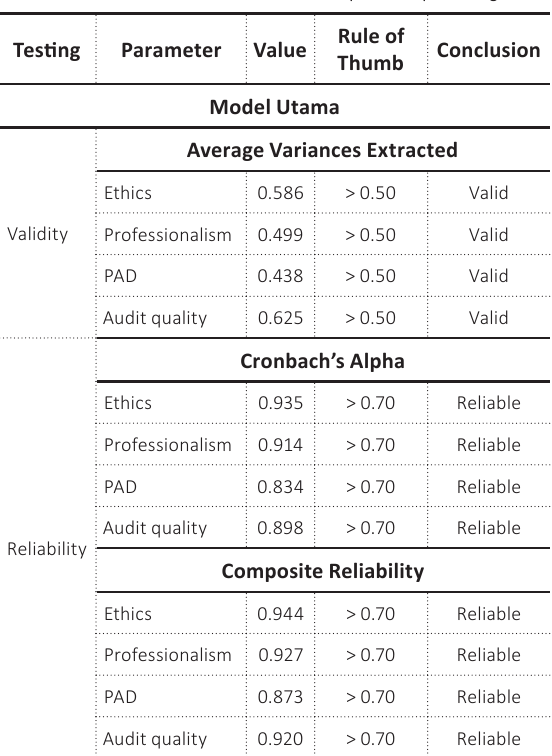
Table 2. Results of the validity and reliability test